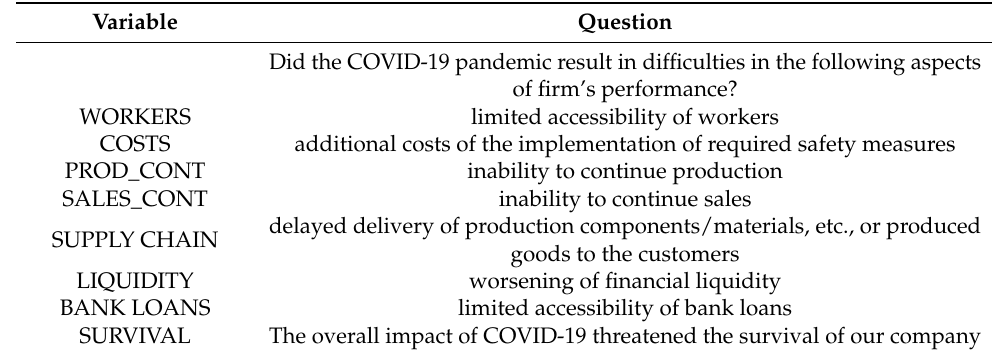
Table 1. Survey design: questions on COVID-19